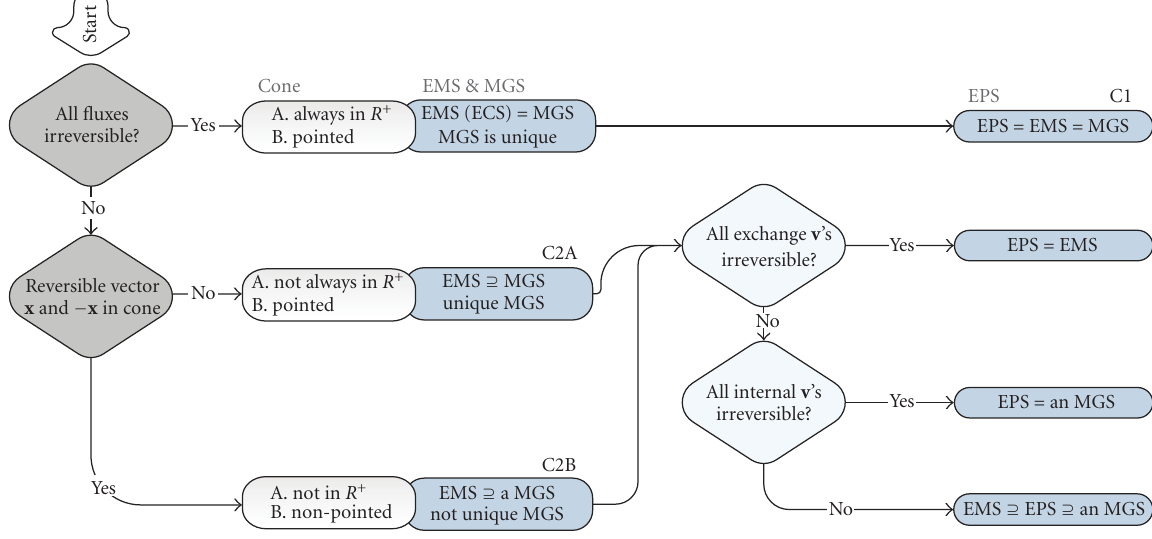
Figure 3: Relationship between di ff erent network-based